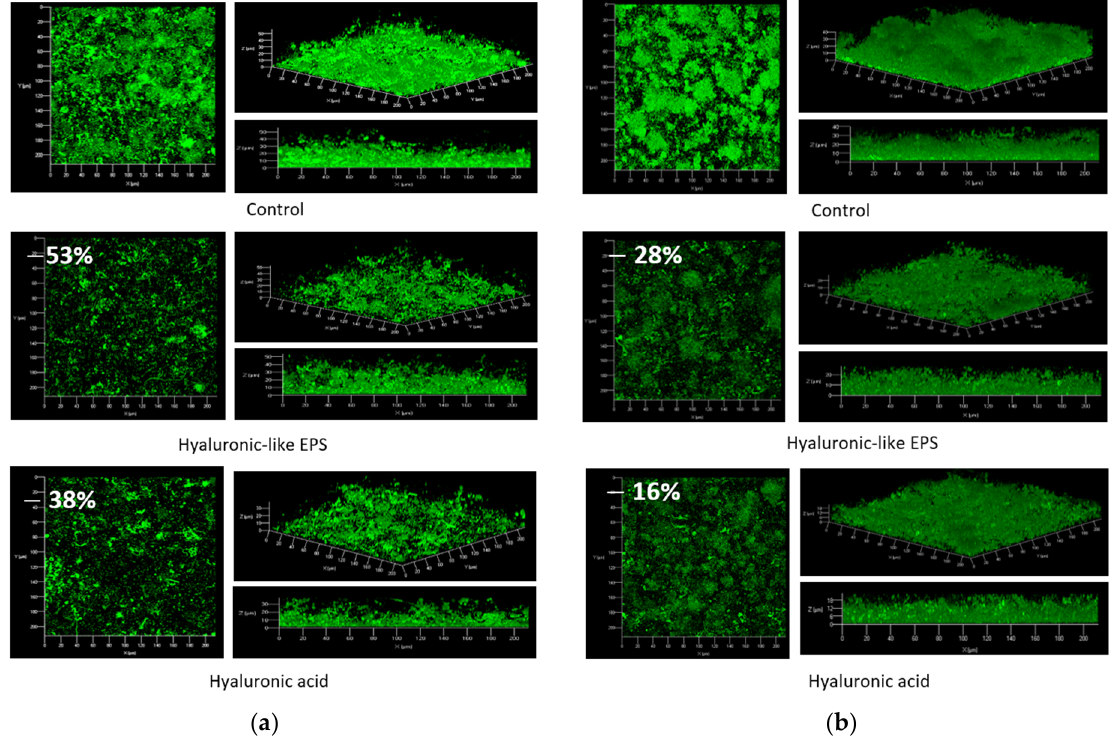
Figure 8. Prevention ( a ) and disruption ( b ) of V. harveyi biofilms (syto9 ® ) with hyaluronan-like EPS or HA in a flow cell. Flow cells irrigated by a medium were inoculated at 28 °C for 24 h with and without (control) 125 µg/mL of hyaluronan-like EPS or HA. Images and structures of biofilms in flow cells were detected by CLSM. The biomasses of biofilms in flow cells were analyzed using COMSTAT software and biofilm percentages (%) were determined compared to the control (Adapted with permission from Ref. [133]. 2022 MDPI).